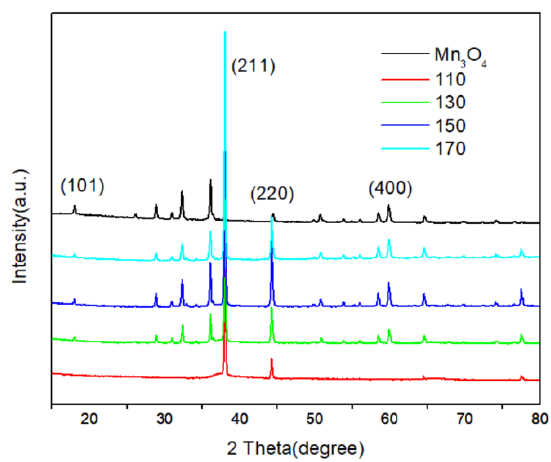
Figure 1. X ‐ ray diffraction patterns of prepared particles at various temperatures for 4 h. (From top to bottom: Commercial nanosized Mn 3 O 4 ; 170; 150; 130; 110 °C). bottom: Commercial nanosized Mn 3 O 4 ; 170; 150; 130; 110